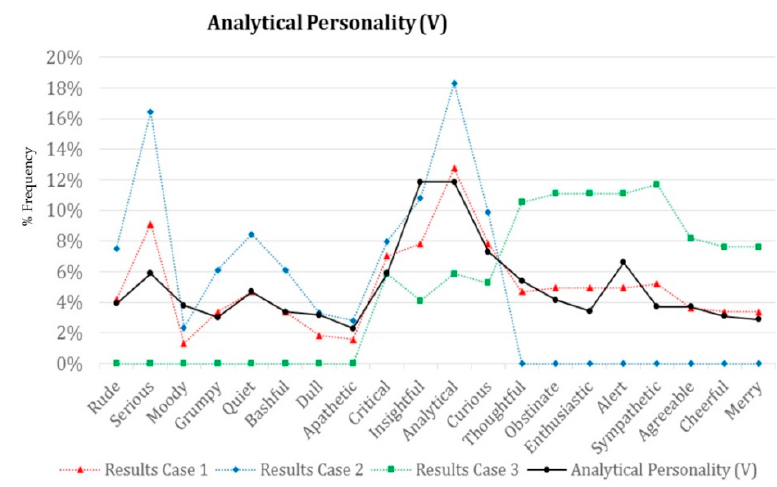
Figure 18. Comparison of cases for an Analytical Personality.